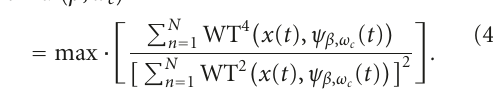
and corresponds to the wavelet centre frequency in frequency domain, and A is an arbitrary scaling factor. Figure 3 shows the Laplace wavelet, its real part, imaginary part, and its spec-